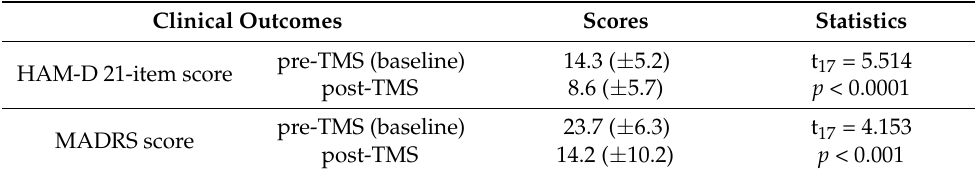
Table 3. Clinical outcome measures following TMS